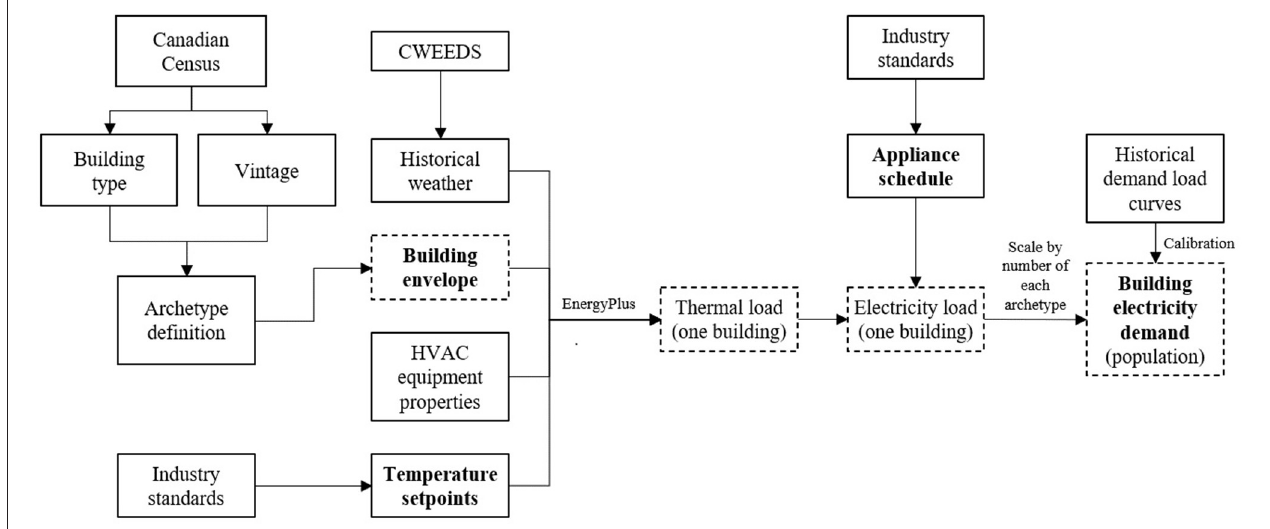
FIGURE 4 | Building model processes, with solid boxes representing raw data inputs and dashes boxes representing a processed output. Note that bold text represents a direct tie-in to Figure 2